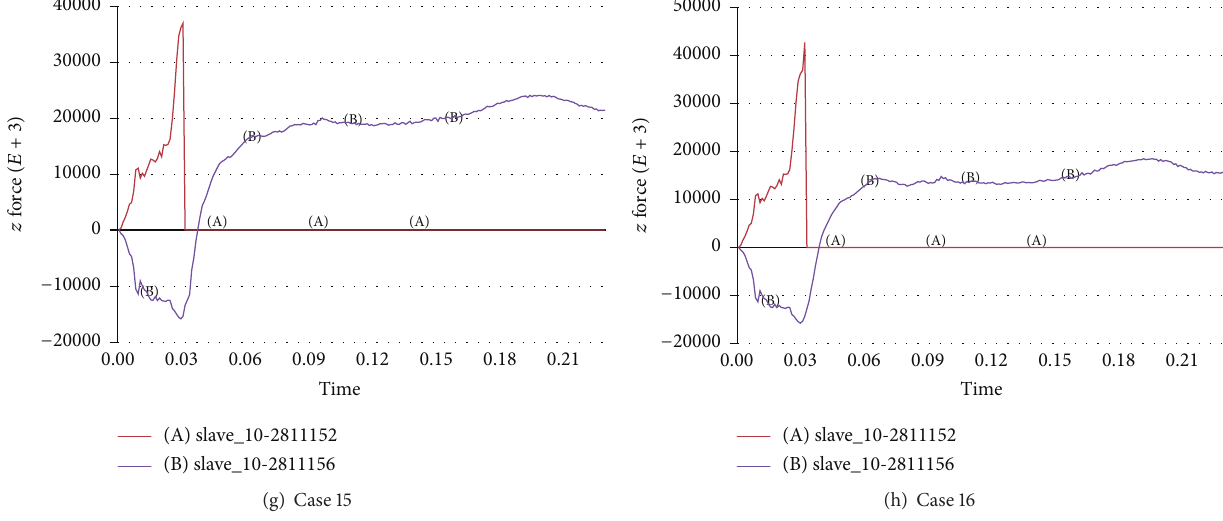
Figure 13: Induced vertical forces in the 𝑧 -axis at the point of failure force measurement (cases 9 ∼ 16, SM490).